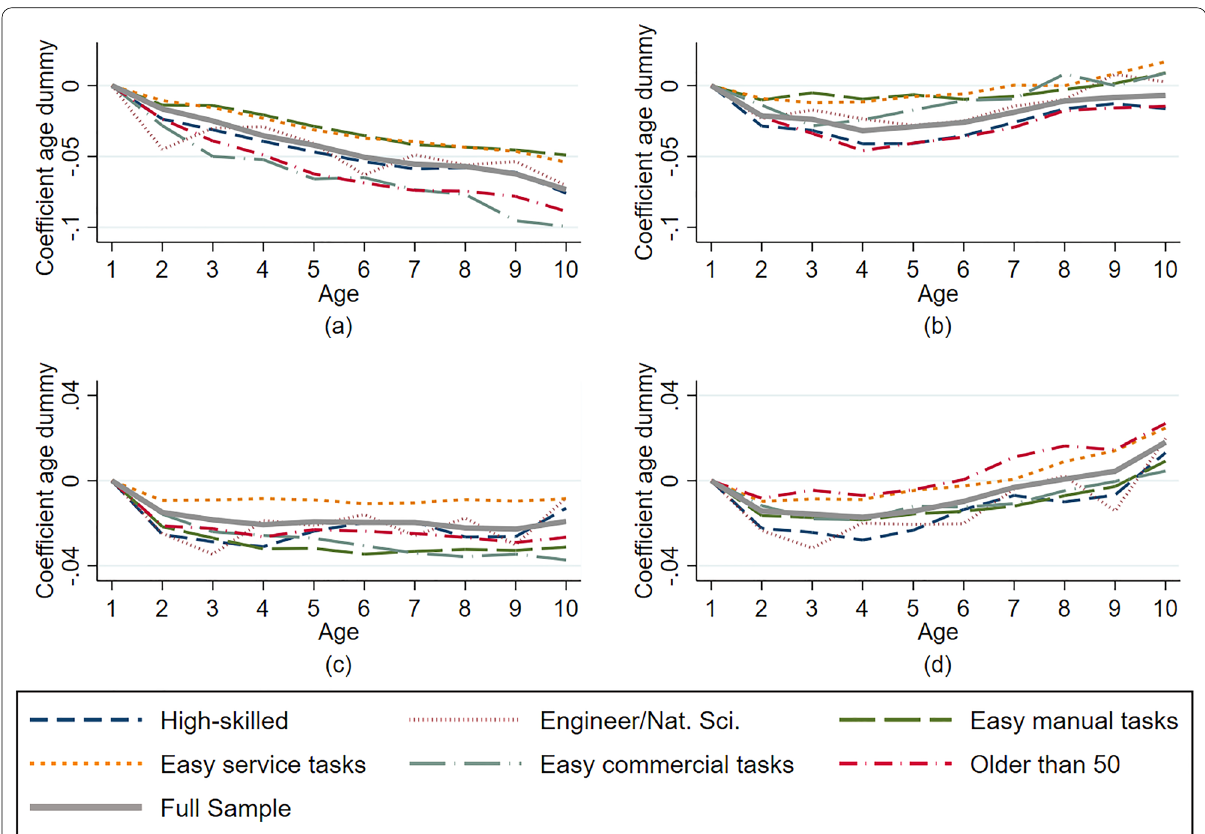
Fig. 17 Evolution of the within-cohort wage dispersion for different establishment types, as measured by the coefficient of the age dummies. In every panel I depict results from the full sample, the sample containing only establishments with a high share of high-skilled employees, the sample containing only establishments with a high share of easy manual, easy service and easy commercial tasks, the sample containing only establishments with a high share of employees that are older than 50 and the sample containing only establishments with at least one engineer and/or natural scientist. a Respectively displays the sample with surviving and exiting establishments that entered between 1996 and 2008 (referring to specification (1) in Table 1). b Respectively displays the sample with only surviving establishments that entered between 1996 and 2008 (referring to specification (2) in Table 1). c Respectively displays the sample with surviving and exiting establishments that entered before 1996 (referring to specification (3) in Table 1). d Respectively displays the sample with only surviving establishments that entered before 1996 (referring to specification (4) in Table 1). For the sake of clarity, I only show point estimates here. Age-cohort cells are weighted with number of establishments per